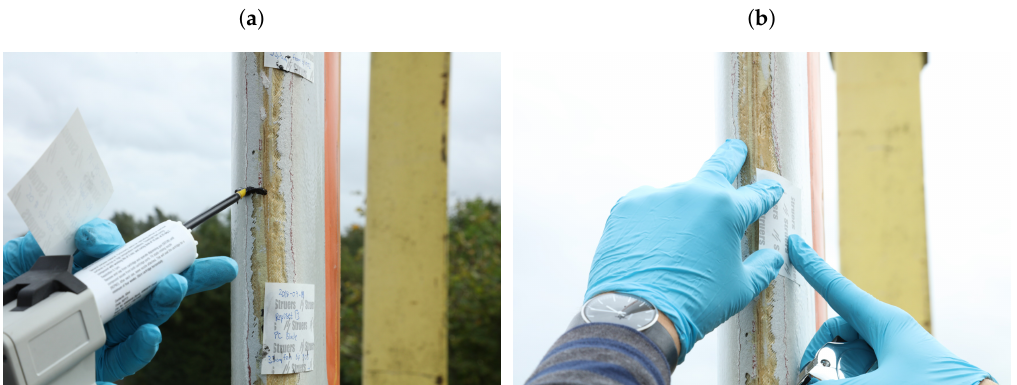
Figure 4. Replication of an area on the blade mock-up. ( a ) illustrates the application of the combined polymer and curing agent from a static-mixing nozzle. ( b ) shows the backing paper being attached by applying a gentle force to the replication